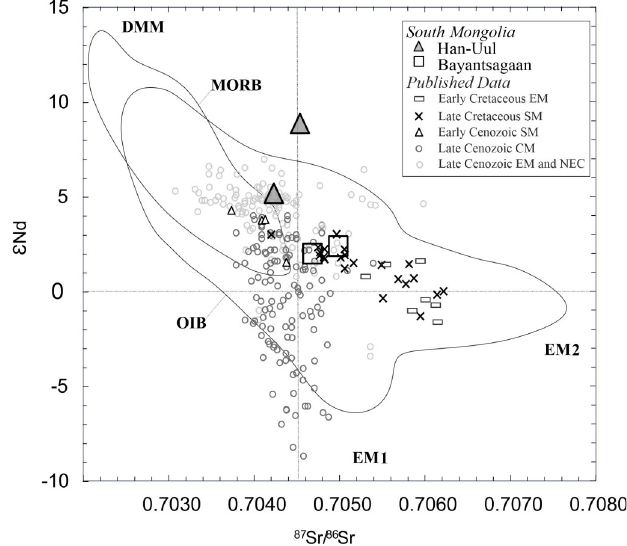
Fig. 7. 143 Nd/ 144 Nd versus 87 Sr/ 86 Sr plot for the late Cretaceous-early Cenozoic basalts from South Mongolia. Previously published Sr-Nd isotopic data for the late Mesozoic-Cenozoic basalts are also plotted for comparison. Data sources are Rasskazov et al. (2002), Yarmolyuk et al. (2003), Barry et al. (2003), Togtokh et al. (2018), Xu and Zheng (2017). Reference fields for DM (depleted mantle), EM1 and EM2 (enriched mantle), MORB (mid-ocean range basalt) and OIB (oceanic island basalt) are from Stracke et al. (2003, 2005). Abbreviation CM-Central Mongolia, NEC-